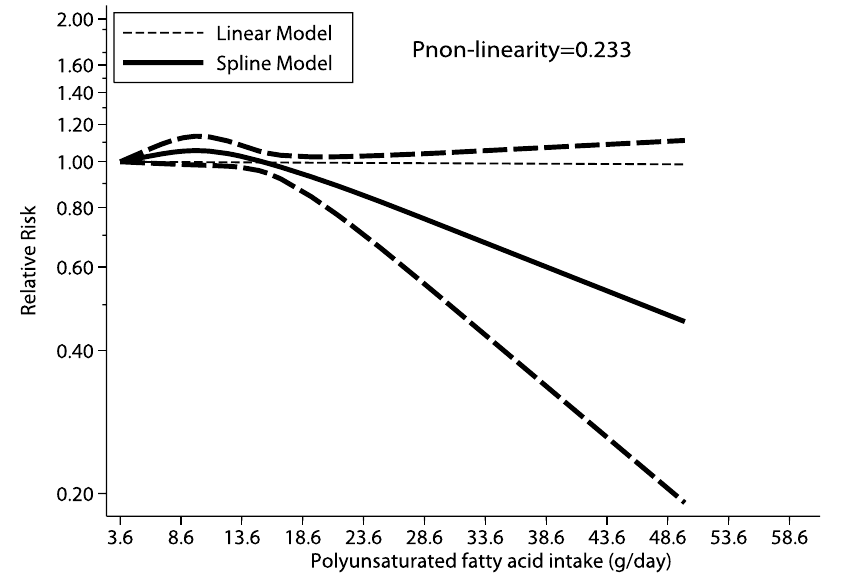
Figure 3. Dose-response relations between PUFA intake and relative risks of lung cancer.